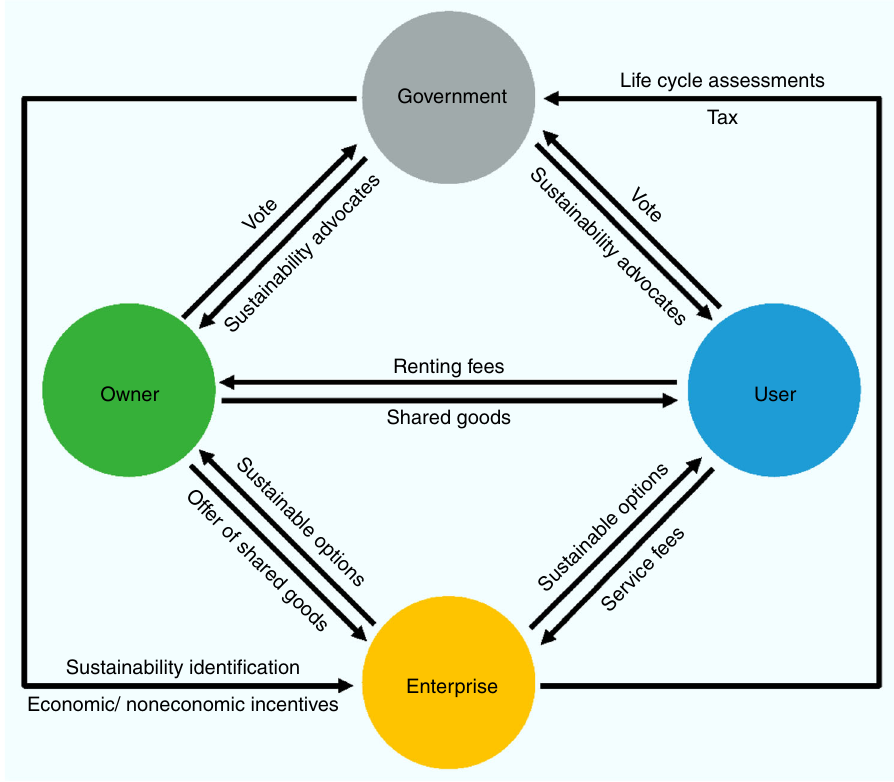
Fig. 1 Framework for sustainable model of sharing economy. The framework involves four participants, including governments, enterprises, owners and users. Governments identify the most pro-social sharing models and support service providers through both economic and noneconomic incentives. Enterprises estimate the environmental impacts of sharing activities from life-cycle perspectives and provide sustainable information and options to consumers. Owners and users of shared products make sustainability a key factor in selecting sharing service